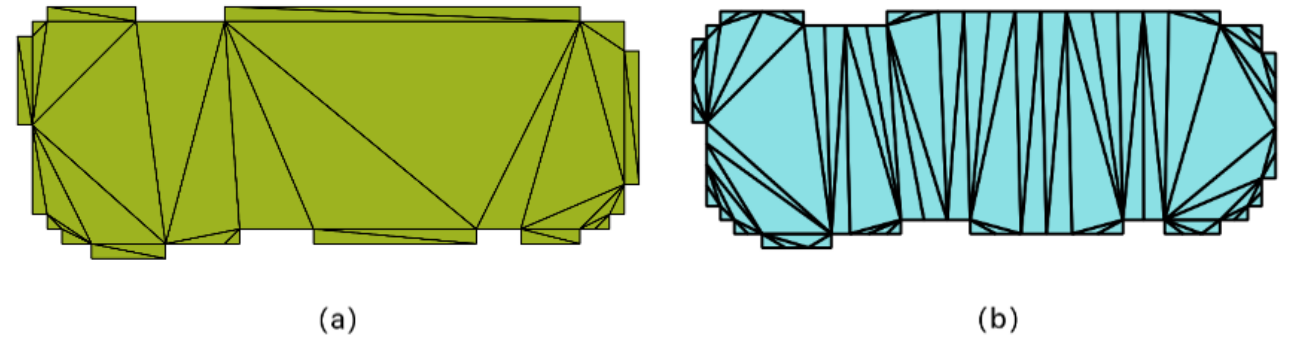
Figure 1. CDT. ( a ) Before encryption; ( b ) after encryption. According to the classic skeleton line extraction method proposed by DeLucia and Black [11], triangles can be divided into three types (1–3) according to the number of adjacent